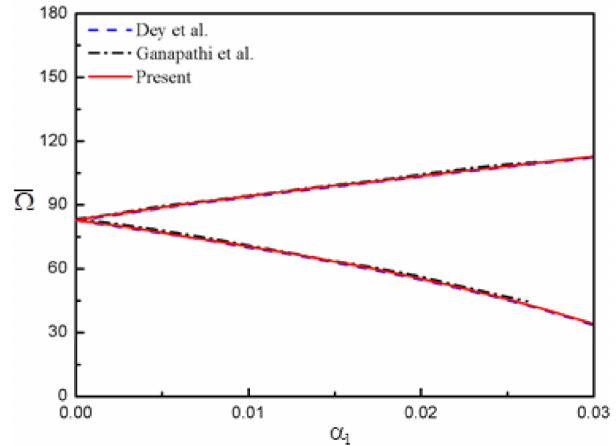
Figure 9. The dynamic unstable regions of a cross-ply laminated composite cylindrical shell ( L / R = 1, R / h = 100) subjected to uniform periodic in-plane loading.